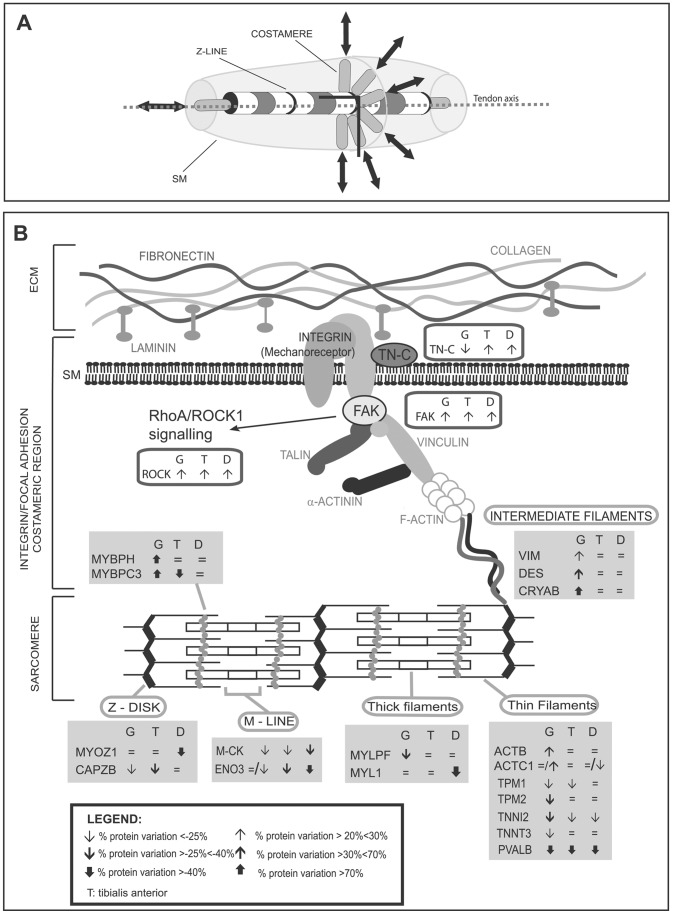
Costameric schematization, immunoblotting and proteomic results of proteins involved in mechanotransduction.Panel A: schematic representation of costameres and force transmission by ECM. The junction between cell matrix to the muscle cell is represented by costameres which consist of a complex protein network that forms a physical attachment of the underlying, outer Z discs of the muscle cell to its surrounding, stress-tolerant, ECM. These specialized sites occur over the entire sarcolemma, where the transmission of force is concentrated (black arrows) from cells to ECM, along and perpendicularly to the tendon axis (dotted grey line) with the role of keeping sarcolemma aligned with nearby contractile structures [79], [80]. The absence of collagen VI would alter the signaling from the interstitial connective tissue to the muscle fiber and tendon [1], [2], [4], [81]. Panel B: Graphical representation of the muscle unit involved in mechanotransduction in which deregulated proteins are indicated. For details see Table S1. Grey and empty rectangles contain gene names of deregulated proteins observed by 2D-DIGE and western blotting, respectively. Arrows indicate the protein trend in gastrocnemius (G), tibialis (T) and diaphragm (D). For 2D-DIGE results, the arrows direction indicates the up and down regulation, the thickness the % of spot variation, as described in “legend”.  = /↓ or  = /↑ indicate the differential expression of isoforms of the same protein in a given muscle. For western blotting, the arrows direction indicates the up and down regulation of relative variation of Col6a1−/− versus control muscle.